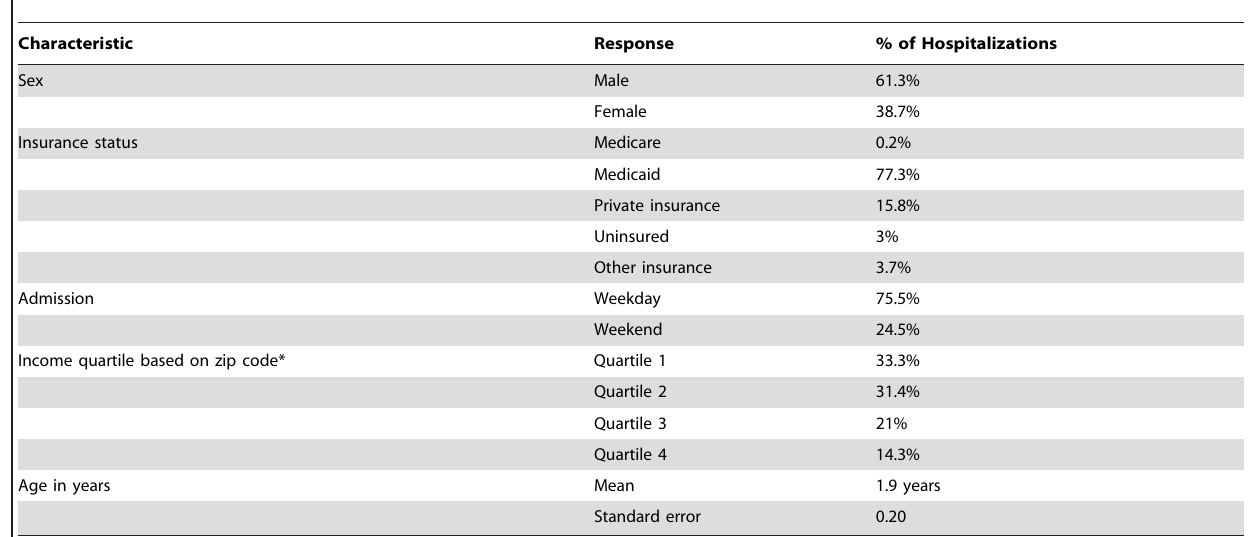
Table 4. Characteristics of Hospitalizations (admitted as inpatient into same hospital following ED visit) [N =5,182).